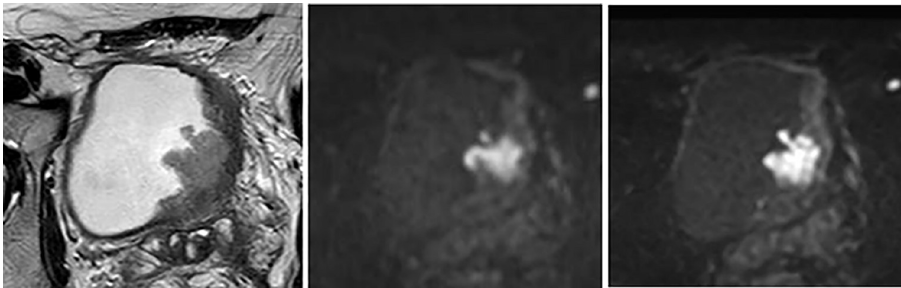
Fig 6. 66-year-old man with the urothelial carcinoma of pT2 on the anterior wall of the bladder. (A) T2WI (B) fFOV DWI (C) Zoomed DWI. The tumor appeared as a lesion without stalk in both fFOV and Zoomed DWI, and score of VI-RADS was 3 for both fFOV and Zoomed DWI